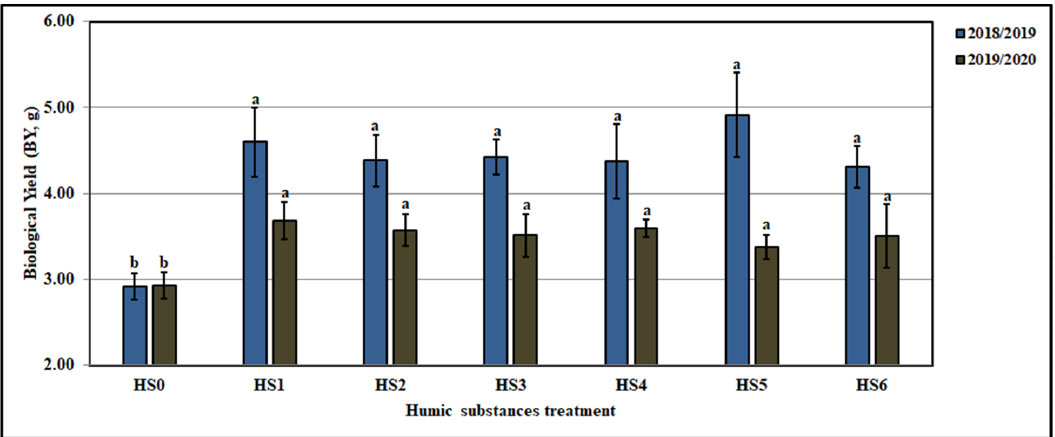
Figure 14. Influence of humic substances treatments on biological yield (BY, g plant − 1 ) of some wheat varieties grown in clay loam soil in 2018/2019 and 2019/2020 seasons. Bars in the same years with a different letter indicate significant differences between treatments at p ≤ 0.01. HS 1, HS 2 , HS 3 represent HS applied as foliar spray at 1.0, 2.0, 4.0 g L − 1 , respectively, HS 4 , HS 5 , HS 6 represent HS applied as soil application at 5.04, 7.56, 10.08 kg ha − 1 .